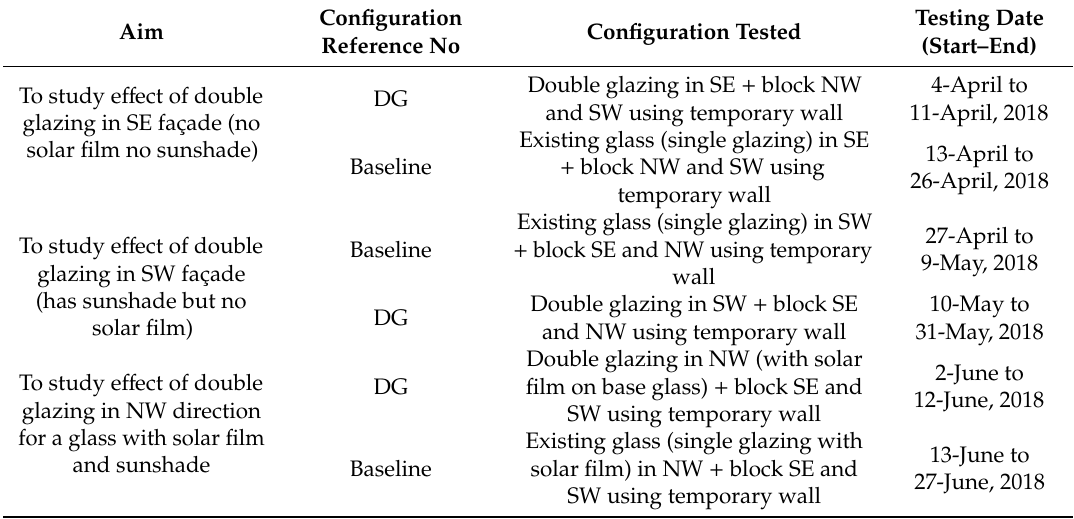
Table 4. Design of